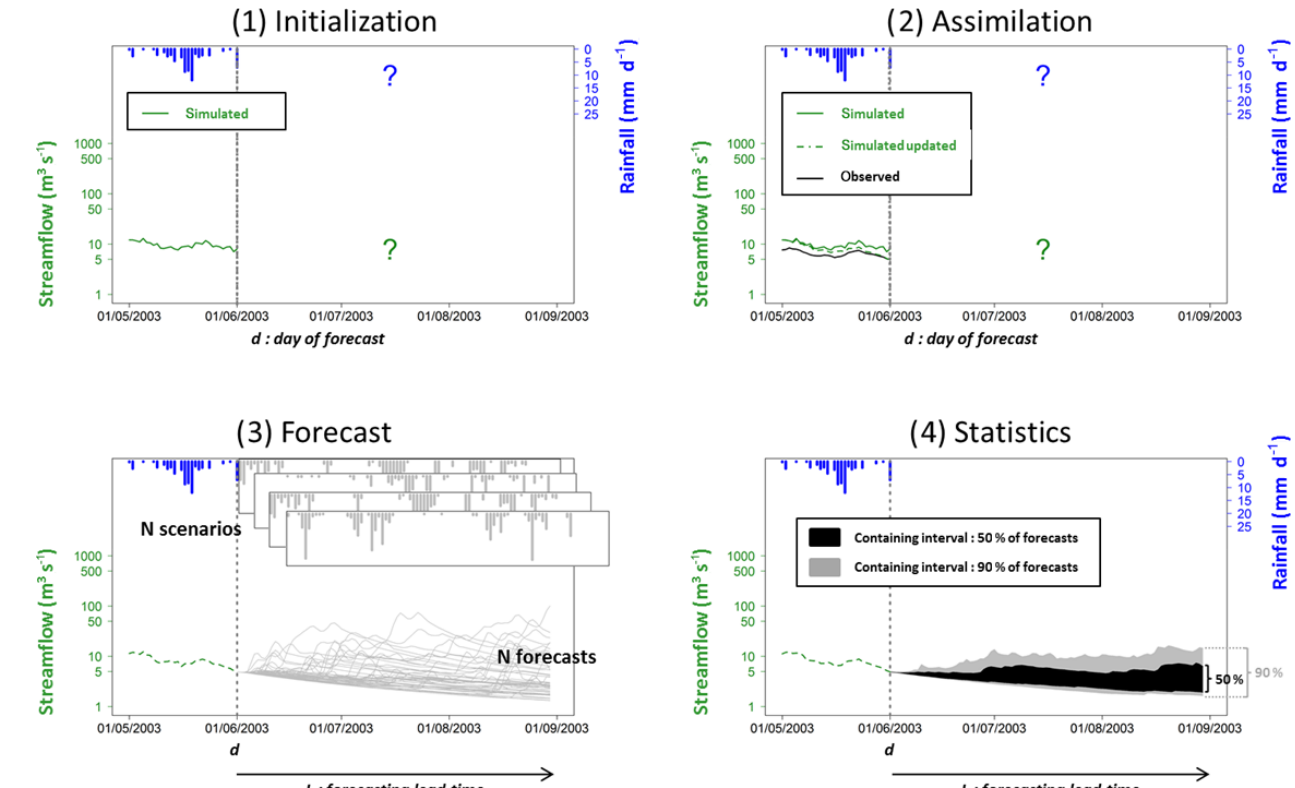
Figure 2. Forecasting method for low-flow forecasting with hydrological